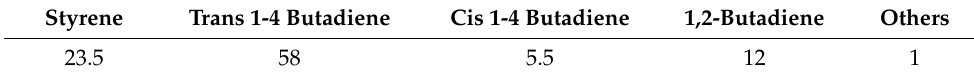
Table 8. Content of styrene butadiene rubber polymer structure repeat unit (w%).